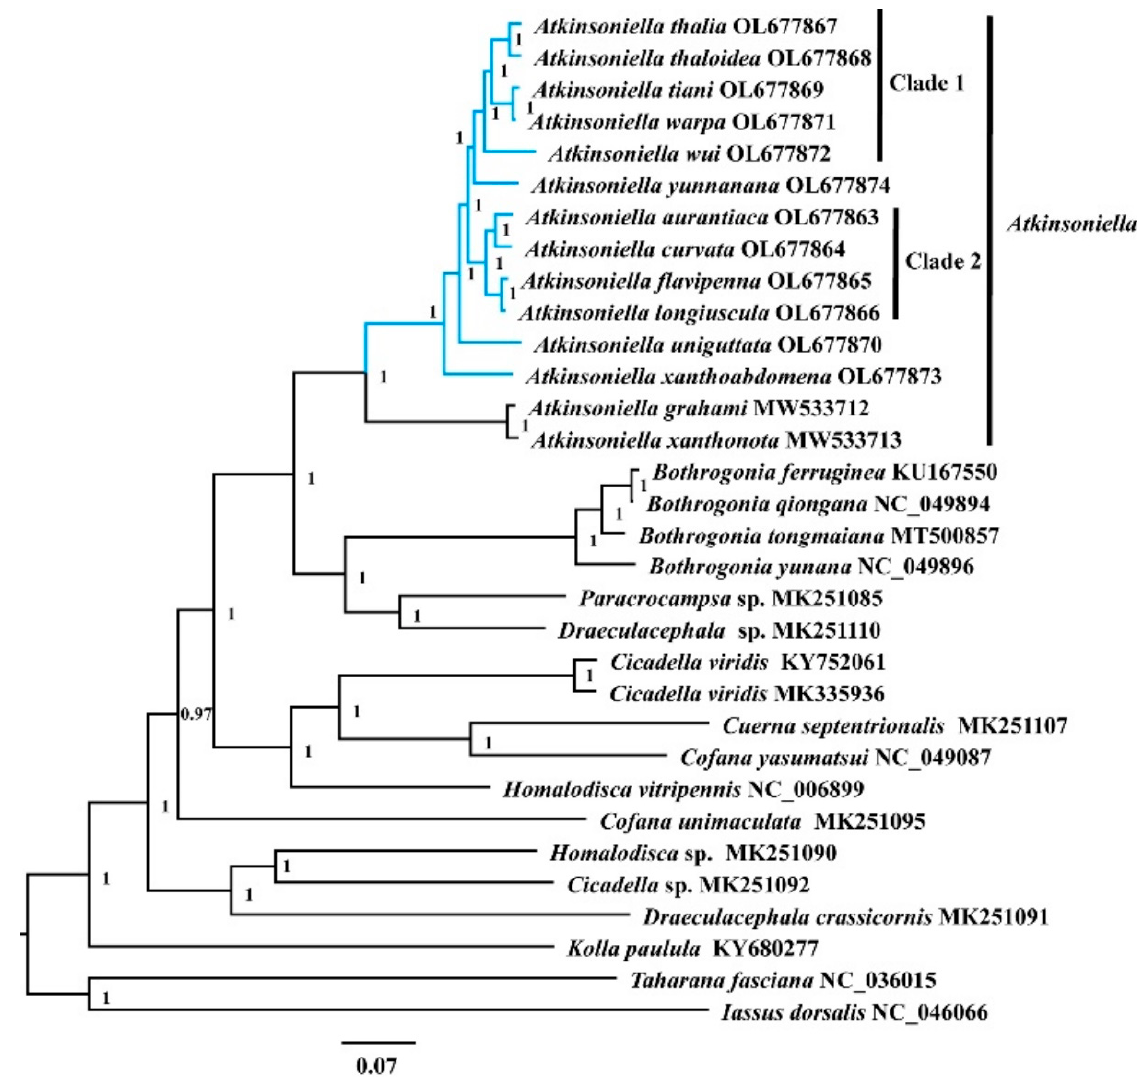
Figure 6. The phylogenetic relationships of Cicadellinae using the Bayesian inference (BI) method based on the concatenated amino-acid sequences of the PCG (cds_faa) dataset. Numbers on branches are posterior probabilities (PP). The blue clades represent the 12 newly sequenced Atkinsoniella mitogenomes in this